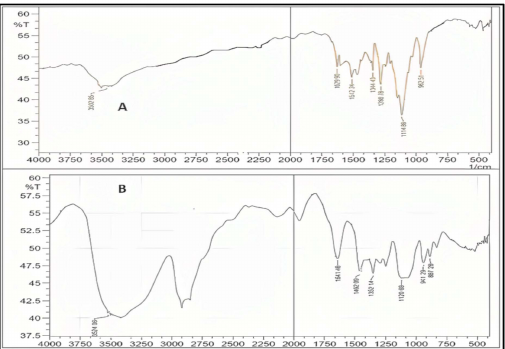
Figure 6. FTIR for pure curcumin ( A ), the optimized formulation of curcumin–NLC F1 ( B ), which shows no chemical interaction with curcumin major peaks, plot %Transmittance vs.